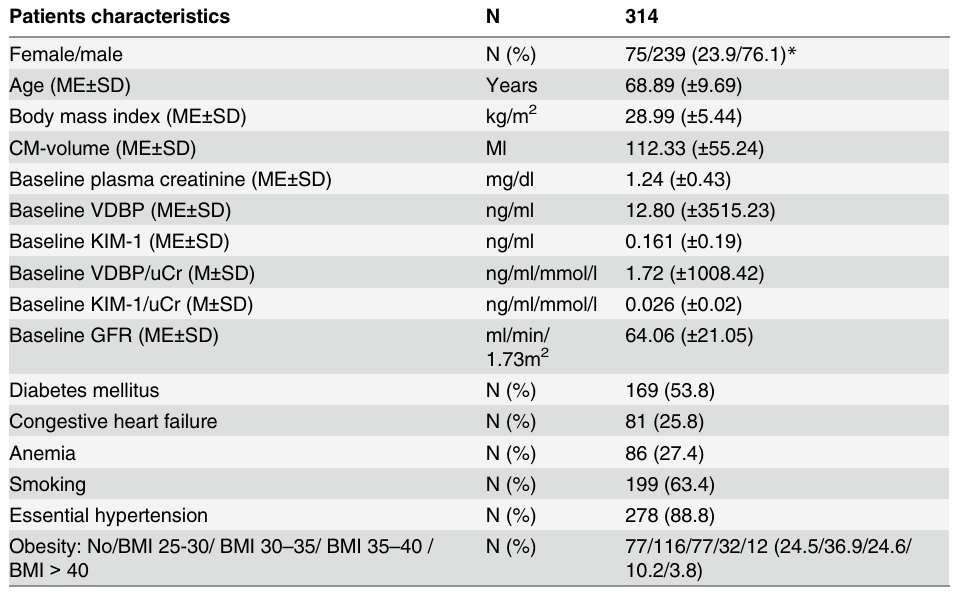
Table 1. Patients characteristics at baseline. CM: contrast media, VDBP: vitamin D binding protein, KIM- 1: kidney injury molecule 1, uCr: urinary creatinine, CIN: contrast induced nephropathy, GFR: glomerulary fil- tration rate estimated with the MDRD formula, ME: mean, M: mean, SD: standard deviation, * — p < 0.05 is sta- tistically significant. Patients